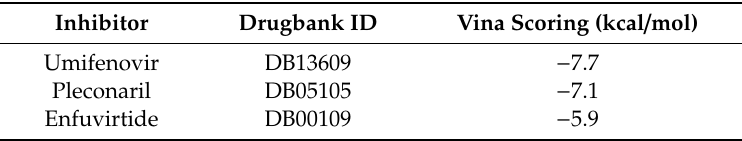
Table 2. Results from molecular docking with Autodock